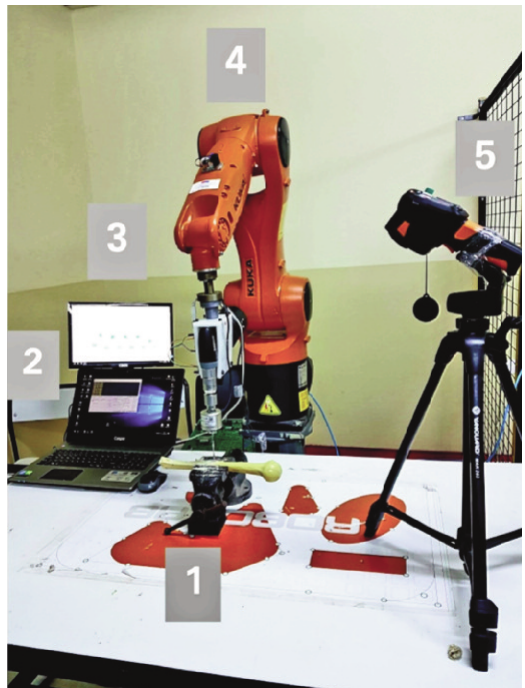
Experimental setup: (1) Compressed humerus sawbone [Synbone ® , Swiss] in a clamp. (2) Computer where data and Fig. 2: measurements are saved. (3) Drill attachment, measuring sensors and drill. (4) Robotic arm [Kuka Kr900 ® , Kuka Roboter GMBH]. (5) Thermal camera [Testo 869 ® ].